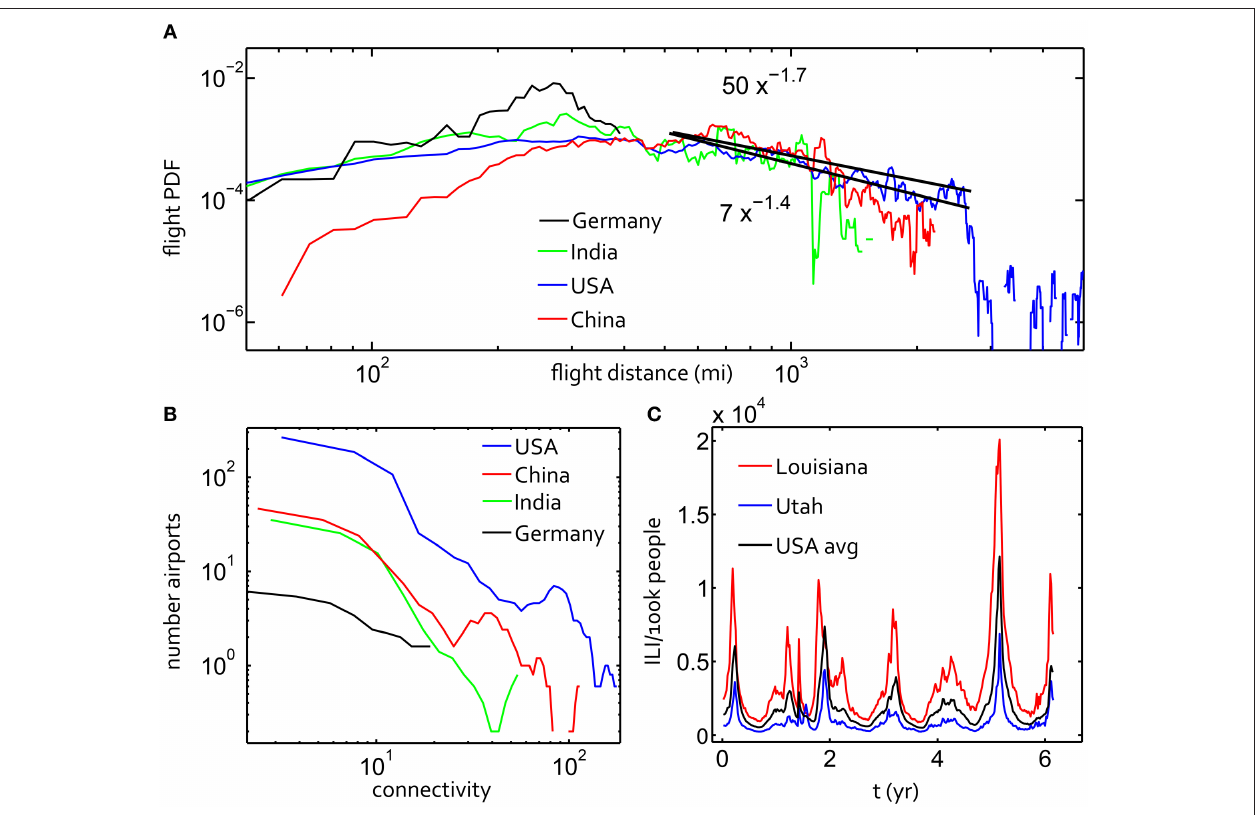
FIGURE 1 | (A) The probability of a flight/step of a certain number of miles within a week-long time interval for displacements on the air travel networks in the USA, China, Brazil and India. Considering the power law scaling − (1 + α ) of this data for flight distances between 400 and 2,500 miles, black lines are fit for α = 0.3, α = 0.6, α = 0.9. (B) Distribution of connectivity for these four countries’ flight networks. (C) Google Flu Trends for the USA average and for two states with noticeably different